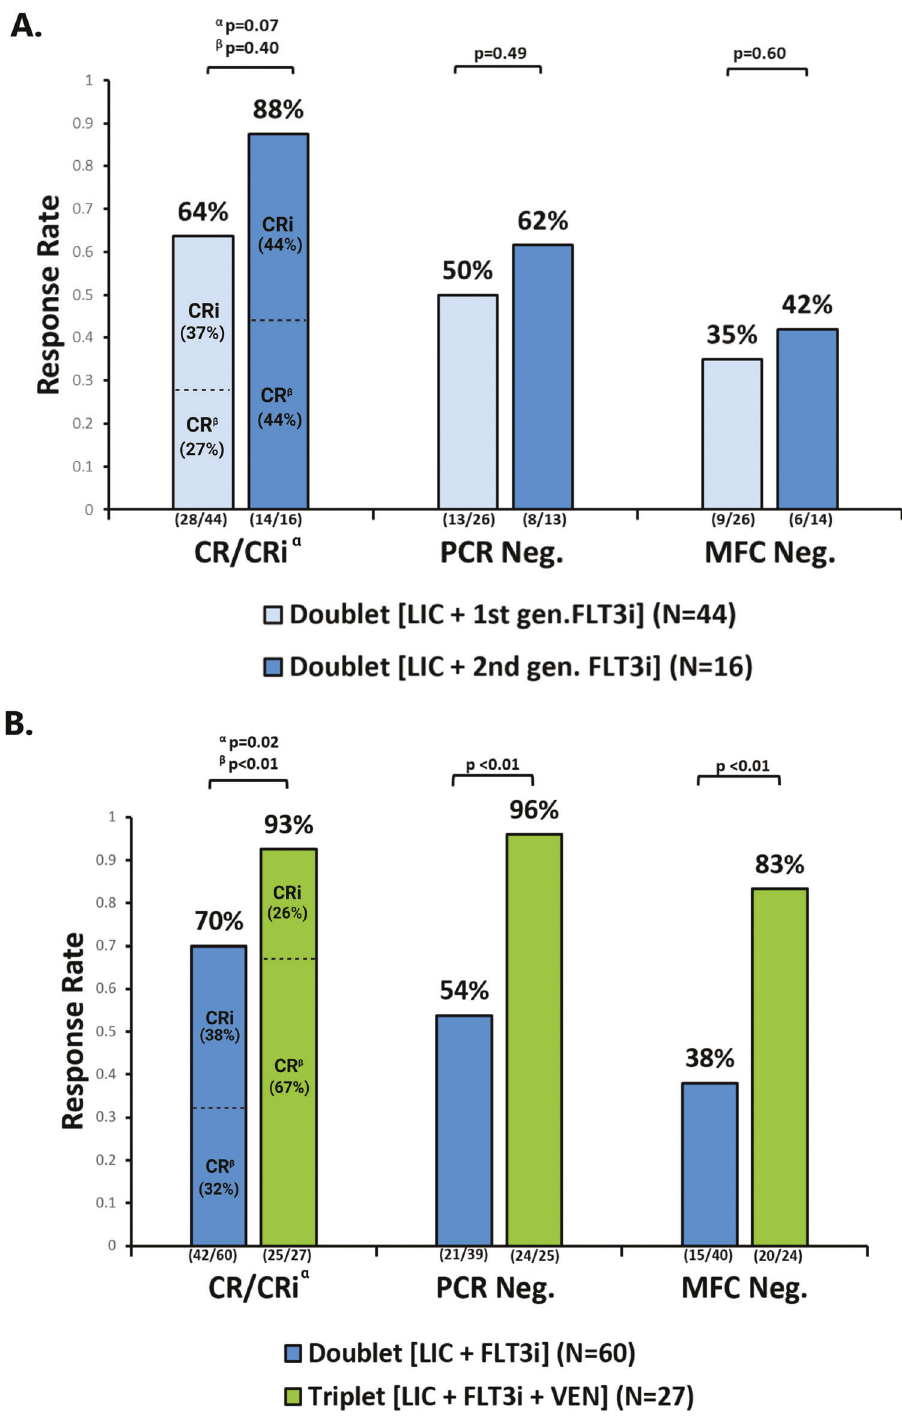
in patients treated in the three groups: Triplets, doublets with second-generation (quizartinib or gilteritinib) FLT3 inhibitors, and doublets with fi rst-generation (midostaurin or sorafenib) FLT3 inhibitors, were NR, 15.7 months, and 8.7 months, respectively ( P < 0.01) (Fig. 4B). There was no statistically signi fi cant OS difference between patients treated with fi rst- versus second-generation FLT3 inhibitor based doublets ( P = 0.19) (Fig. 4B). RFS was also longer in the triplet arm than in the doublet arm ( p = 0.03) (Supplementary Fig.